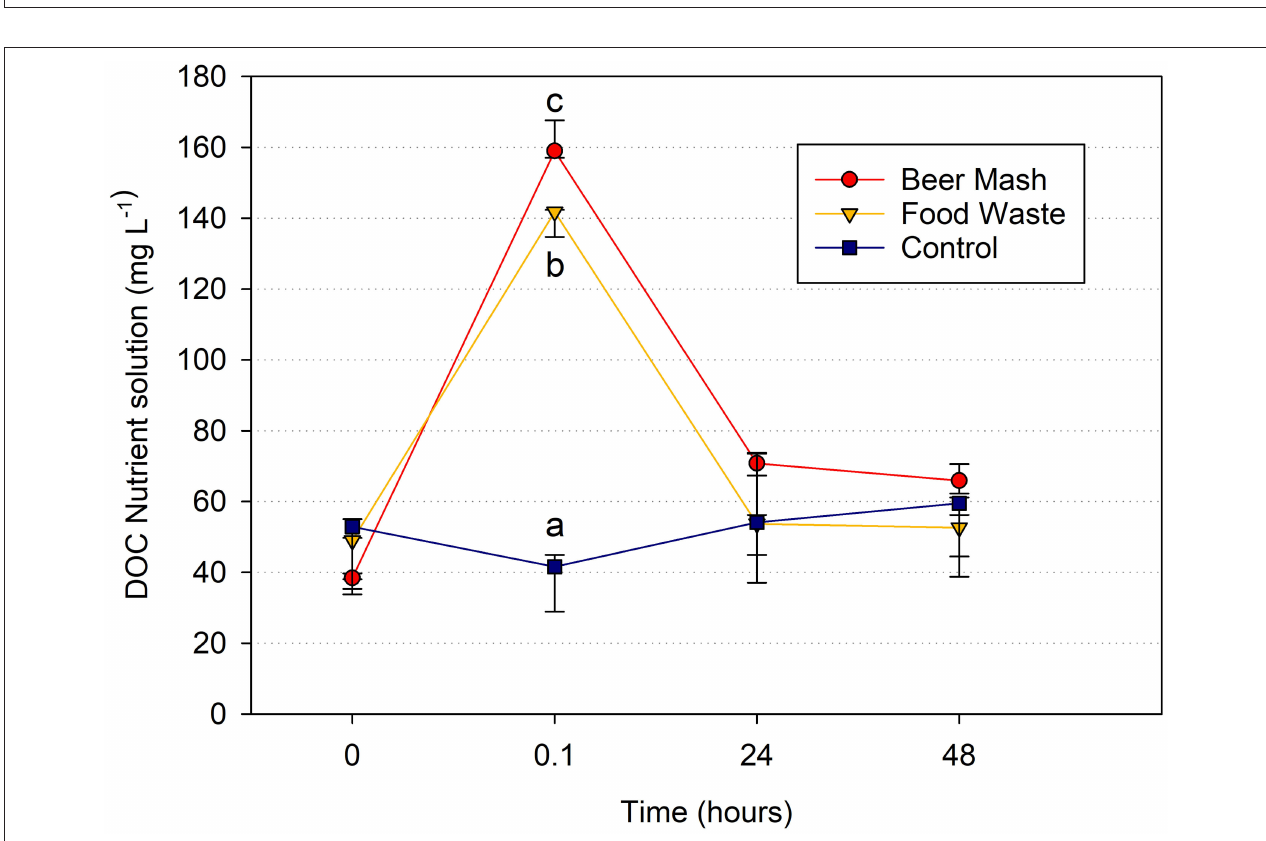
FIGURE 6 | Dissolved Organic Carbon (DOC) changes in the nutrient solution. Average DOC concentration vs. time detected by DOC analyzer in a greenhouse experiment with citrus as the host plant at week 4. We chose to report week 4 because it is representative and because it was a middle point in the experiment. Treatments consisted of nutrient solution receiving no digestate (Control) or amended with beer mash BM or food waste FW digestate at time zero. Time points (0, 0.1, 24, and 48h) with different letters are significantly different at P = 0.01 according to the all pairwise multiple comparison procedures (Holm-Sidak method). Error bars represent the SE of the mean ( n = 3) where variation was great enough to be